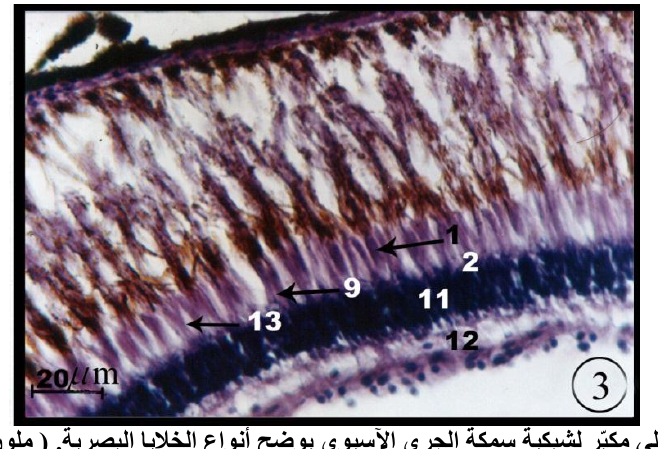
0: Cone ; 2: External Limiting Membrane; 9: Myoid Element 11: Outer Nuclear Layer ; 12: Outer Plexiform Layer ; 13: